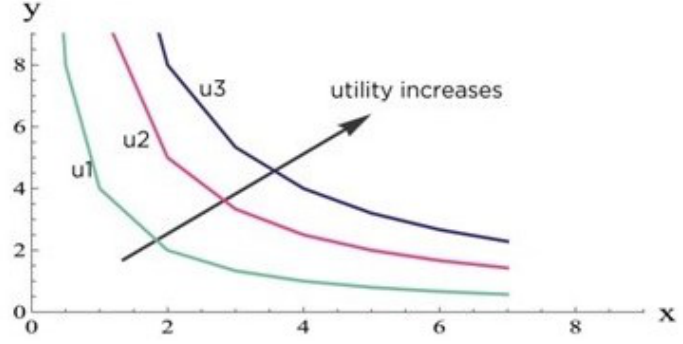
Figure 1. Three different